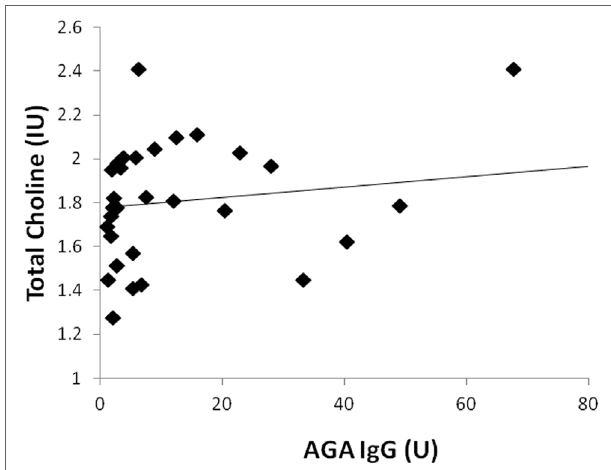
FigUre 3 | Correlation plot showing a positive relationship ( r = 0.36, p = 0.045) between AGA IgG and GPC + PC levels. 31/33 of the participants had data